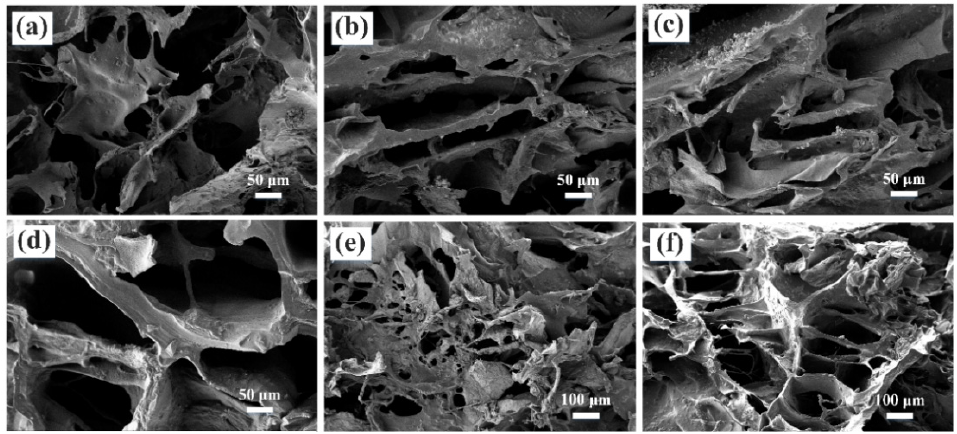
Figure 5. Cross-sectional views of different SA/CHI porous sponges. ( a ) SA3/CHI2-0. ( b ) SA3/CHI2. ( c ) SA3/CHI2-4. ( d ) SA3/CHI2-6. ( e ) SA3/CHI2- M . ( f ) SA3/CHI2- N . ( c ) SA3/CHI2-4. ( d ) SA3/CHI2-6. ( e ) SA3/CHI2- M . ( f ) SA3/CHI2- N